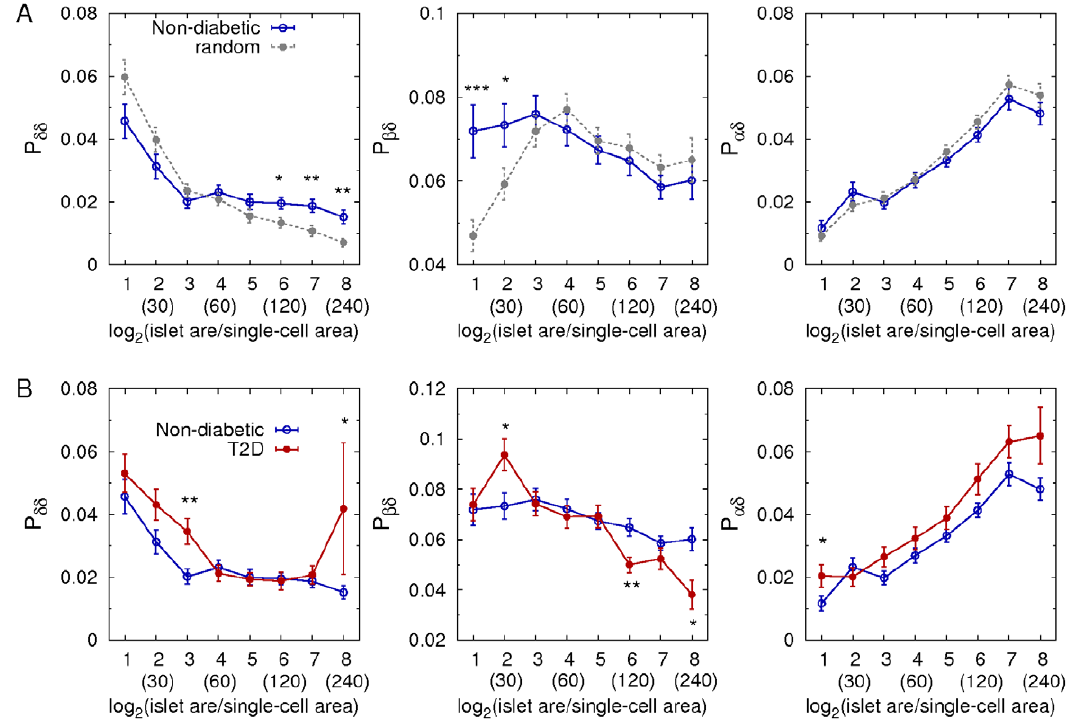
Figure 8. Cellular arrangement of delta-cells. A: Probabilities of delta-delta, delta-beta, and delta-alpha cell contacts in non-diabetic subjects (blue; 6886 islets with n=14). Those were compared with the theoretical estimation for random mixtures of cells (gray) where cellular compositions were the same with the individual islets in non-diabetic subjects (mean 6 SEM). B: Comparison between non-diabetic (blue) and T2D (red; 5359 islets with n=12) subjects. Note that scattered single endocrine cells are excluded in the calculation because contacting cells does not exist for them. The numbers in parentheses represent effective islet diameters ( m m) corresponding to the given logarithmic dimensionless islet areas. Student’s t -test compared the results between non-diabetic and T2D subjects at each size bin with *P , 0.05, **P , 0.001, and ***P , 0.0001.